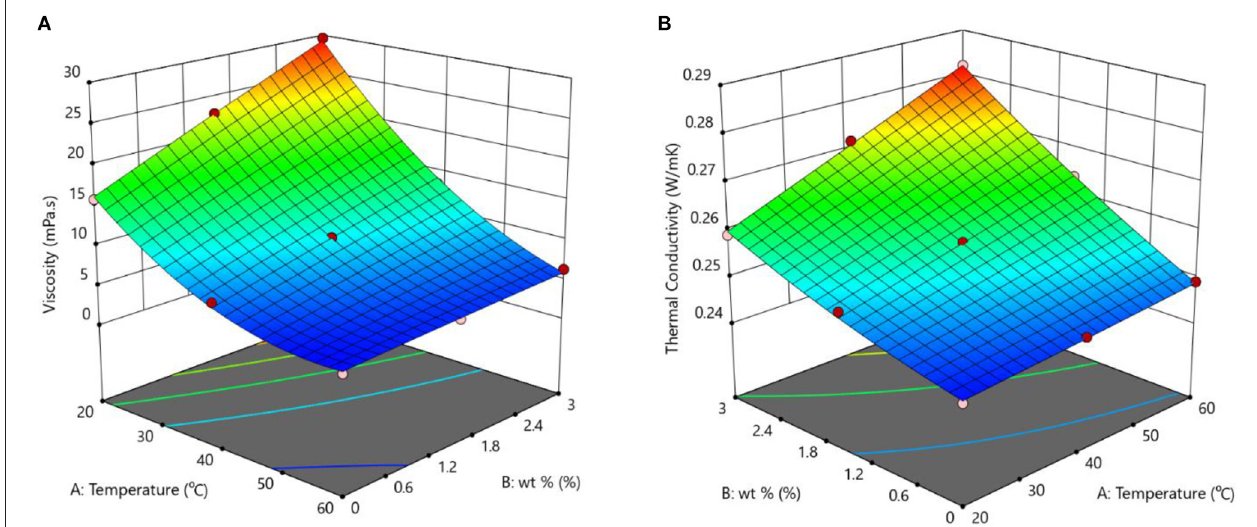
FIGURE 4 | 3D plot for (A) viscosity and (B) thermal conductivity.